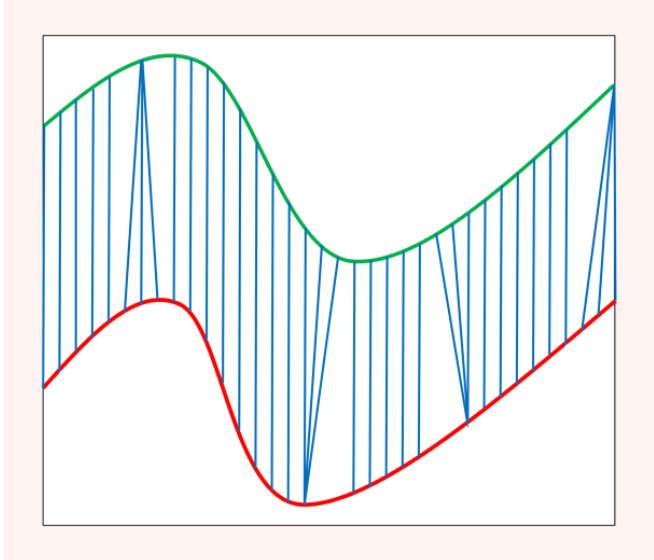
Figure 1. Two sequences aligned with dynamic time warping.